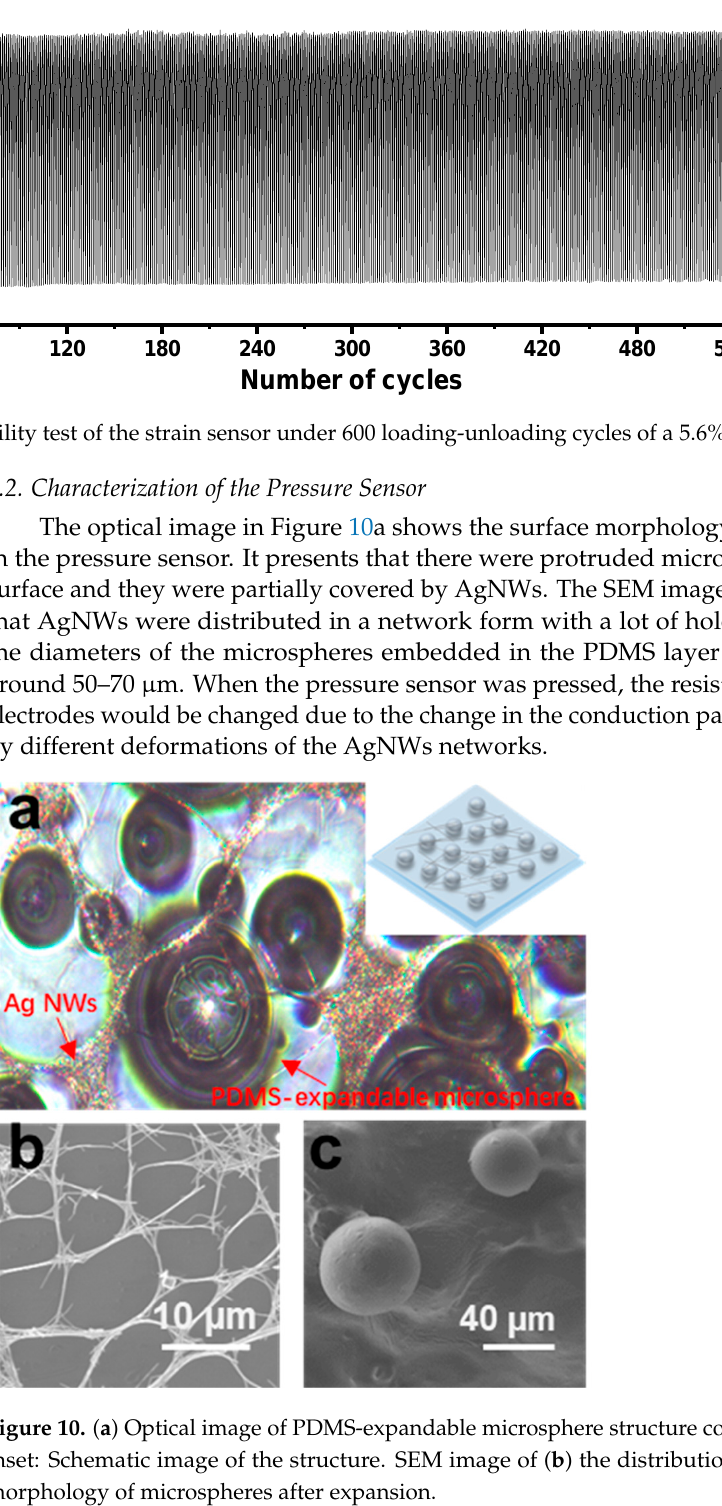
Figure 9 . Mechanical stability test of the strain sensor under 600 loading ‐ unloading cycles of a 5.6% bending strain.